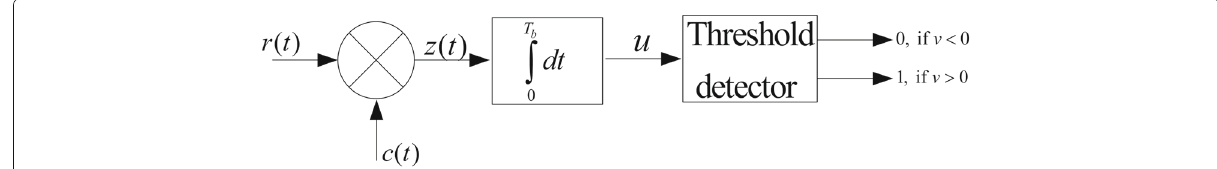
Fig. 1 Direct sequence-spread spectrum receiver